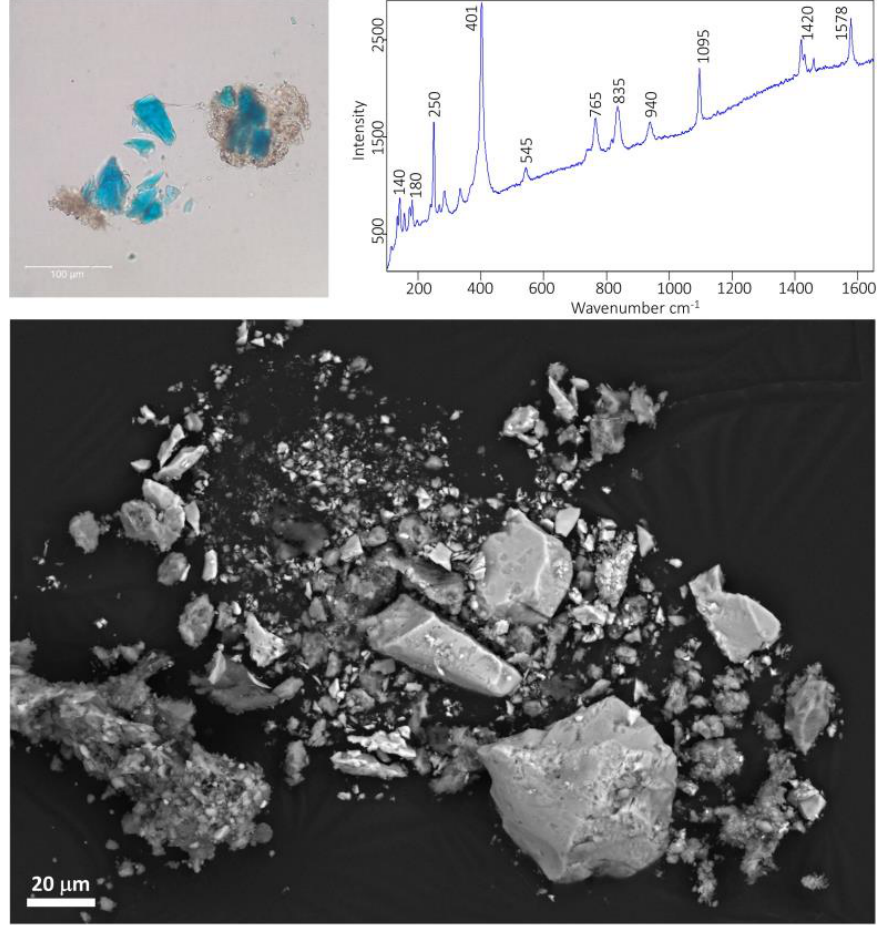
Figure 8. BSE image of sample 1B showing particles shapes and grainsize ( bottom ); PLM image of sample 1B ( top left ) and Raman spectrum measured on one of the blue particles ( top right ).